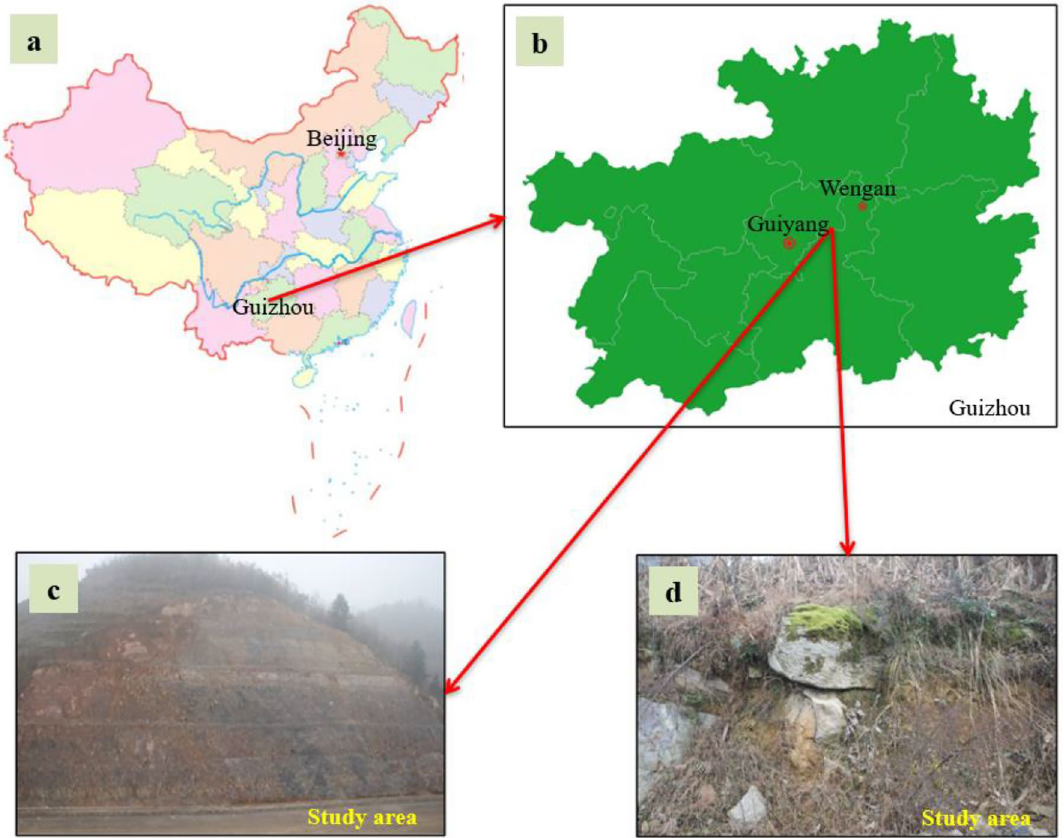
Figure 1. Site condition of landslide. ( a ) Map of China. The base map is accessible on https:// cn. bing. com/ images/ search? view= detai lV2& ccid= MLo78 6tp& id= 4F452 A8986 5BCBE 9C761 A4046 E7074 3661C 7DF99 & thid= OIP. MLo78 6tp5R khIDk BbRGn VwHaG E& media url= https% 3A% 2F% 2Fts1. cn. mm. bing. net% 2Fth% 2Fid% 2FR-C. 30ba3 bf3ab 69e51 92120 39016 d11a7 57% 3Frik% 3Dmd% 252fH YTZ0c G4EpA% 26riu% 3Dhttp% 253a% 252f% 252fx ysj. cditv. cn% 252f2 019% 252f0 801% 252f2 01908 01121 423480. jpg% 26ehk% 3D3JHW% 252fs Loy5m drFyA 0wJJ7 Gabtv 5QCgb J7HaP jhZ84 dQ% 253d% 26risl% 3D% 26pid% 3DImg Raw% 26r% 3D0% 26sres% 3D1% 26sre sct% 3D1& exph= 495& expw= 604& q=% e4% b8% ad% e5% 9b% bd% e5% 9c% b0% e5% 9b% be& simid= 60799 39129 97916 131& form= IRPRS T& ck= E673B 0A016 2B076 A9FA8 6AD60 9AA35 DD& selec tedin dex= 100& ajaxh ist= 0& ajaxs erp= 0& vt= 0& sim= 11 (August 2022). ( b ) Map of Guizhou Province. The base map is accessible on https:// cn. bing. com/ images/ search? view= detai lV2& ccid= U7NXM WND& id= 0AA69 3DA99 B737B 85748 BDFA5 32DD2 898F1 36C31 & thid= OIP. U7NXM WNDa5 iEh7m UObbE QgHaF p& media url= https% 3a% 2f% 2fts1. cn. mm. bing. net% 2fth% 2fid% 2fR-C. 53b35 73163 436b9 88487 b9943 9b6c4 42% 3frik% 3dMWw Tj4nS LVP6vQ% 26riu% 3dhttp% 253a% 252f% 252fw ww. weath er. com. cn% 252fm2% 252fi% 252fg uizhou% 252fj tlycp% 252fg zdt. png% 26ehk% 3dbxL izw0m% 252f9 iEAy2 9W7pc Ahv% 252b2 u8K6I eOu1V 5LFuA LBA% 253d% 26risl% 3d% 26pid% 3dImg Raw% 26r% 3d0& exph= 763& expw= 1000& q=% e8% b4% b5% e5% b7% 9e% e5% 9c% b0% e5% 9b% be& simid= 60805 22171 80004 736& FORM= IRPRS T& ck= 52C4A B3666 72778 72C78 A38DF 23991 5D& selec tedIn dex= 47& ajaxh ist= 0& ajaxs erp=0 (August 2022). ( c ) Study area picture. (d) The site condition of slope. The images of c and d were taken by Gang Tian (one of your